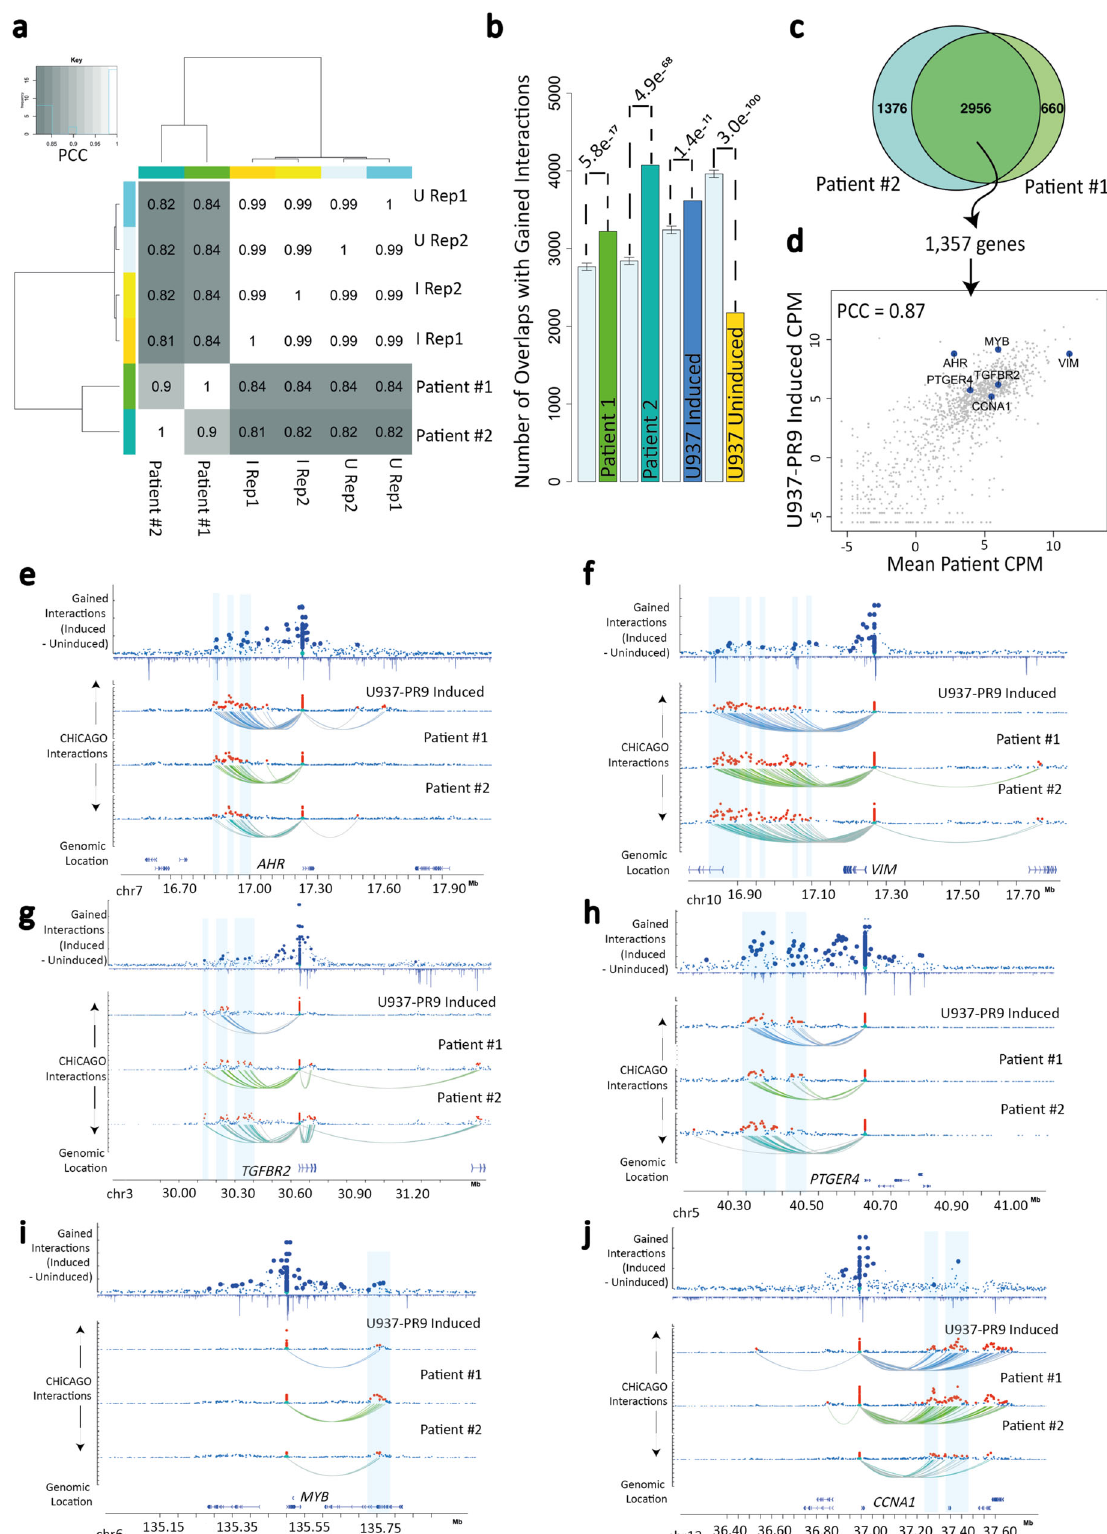
interaction pro fi les (Supplementary Fig. 6l). Taken together, our results indicate that many but not all expression and long-range interaction pro fi les are matched between the cell line model and primary patient samples. Similar expression outputs are frequently a predictor of shared regulatory inputs, although this relationship is not